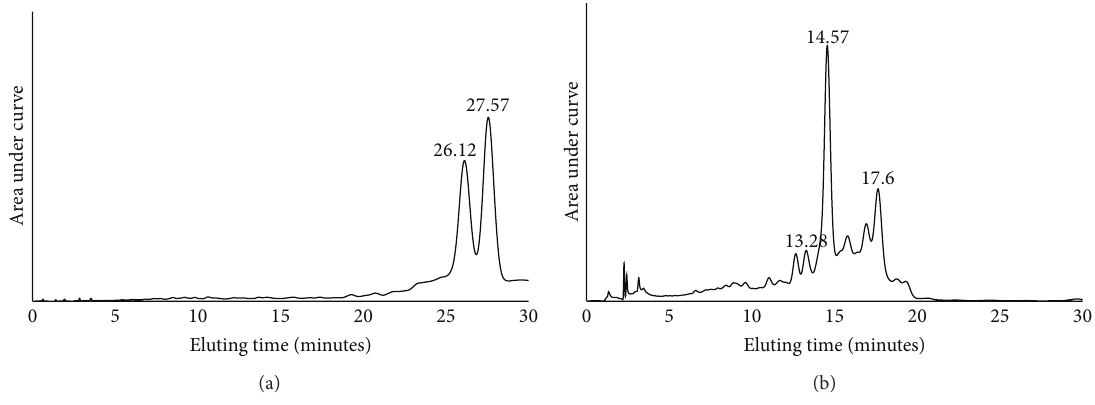
Figure 1: HPLC chromatograms of feruloyl mono- and oligosaccharide arabinoxylans from corn bran (a) and wheat aleurone (b).